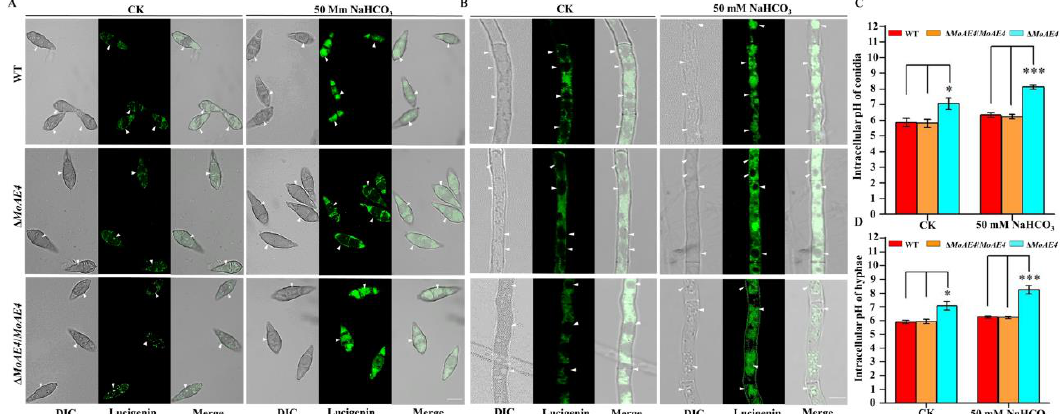
Figure 4. The fluorescence observations and intracellular pH value of the wild type, the ∆ MoAE4 and ∆ MoAE4 / MoAE4 mutant strains. ( A ) The green fluorescence signals in hyphae. The light ( left ), fluorescence confocal ( middle ), and merge ( right ) microscope observations of strains hypha. Bar = 10 µm. ( B ) The green fluorescence signals in conidia. The light ( left ), fluorescence confocal ( middle ), and merge ( right ) microscope observations of strains connidia. Bar = 10 µm. ( C ) The intracellular pH value of conidia. Δ MoAE4 strains were obviously higher than the wild-type strains under 50 mM sodium bicarbonate. ( D ) The intracellular pH value of the strains in hyphae. Under 50 mM sodium bicarbonate conditions, the intracellular pH of ∆ MoAE4 strains remained high in hyphae. The data represent means ± standard deviations (SD) of three experiments. * p < 0.05. *** p <